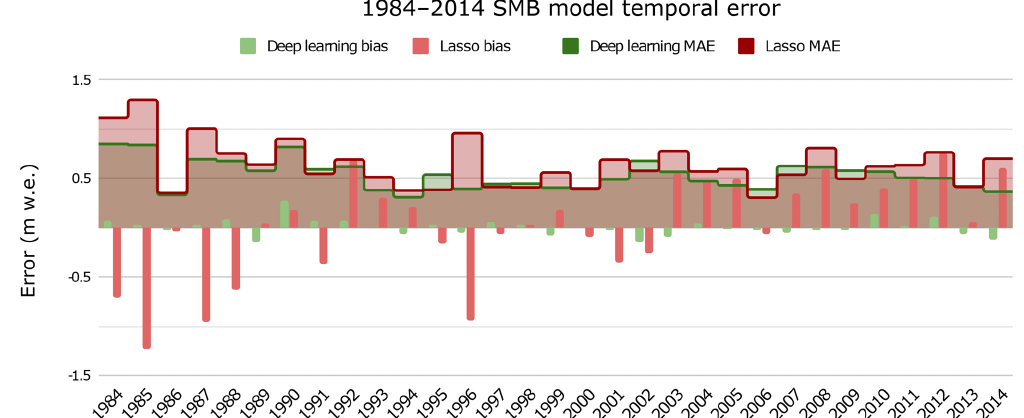
Figure 10. Mean average error (MAE) and bias (vertical bars) for each year of the training dataset for the 1984–2014 LOYO glacier-wide SMB